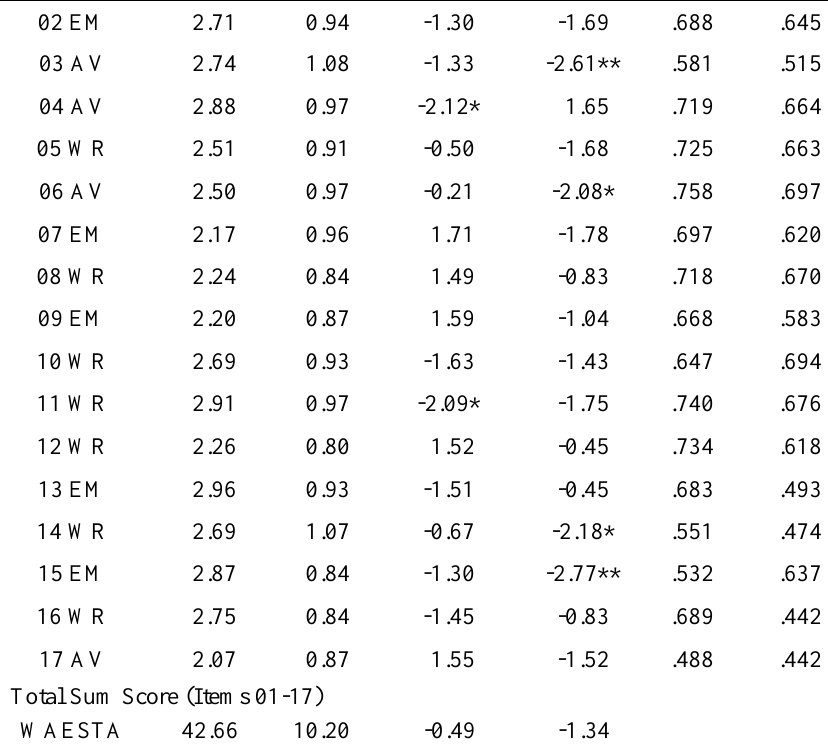
Descriptive statistics, factor loadings and corrected item-test correlations of WAESTA items (WR = worry, AV = avoidance, EM = emotionality): Results from the construction